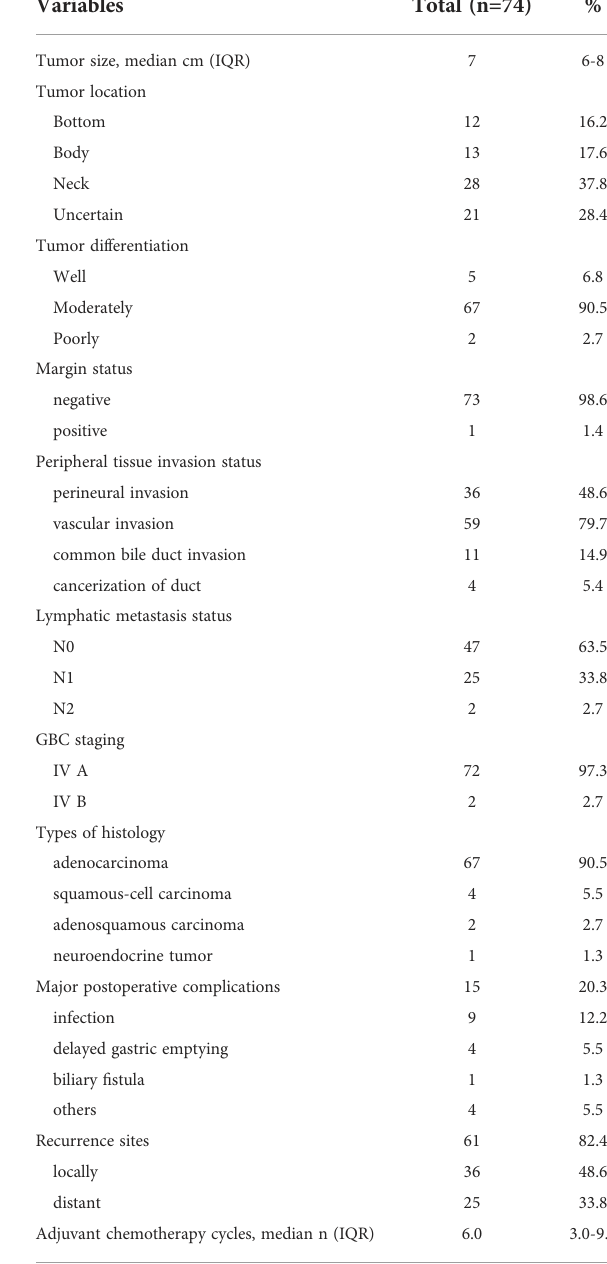
TABLE 1 The baseline characteristics and perioperative variables of gallbladder cancer patients who underwent extended resection. Variables Total (n=74) %